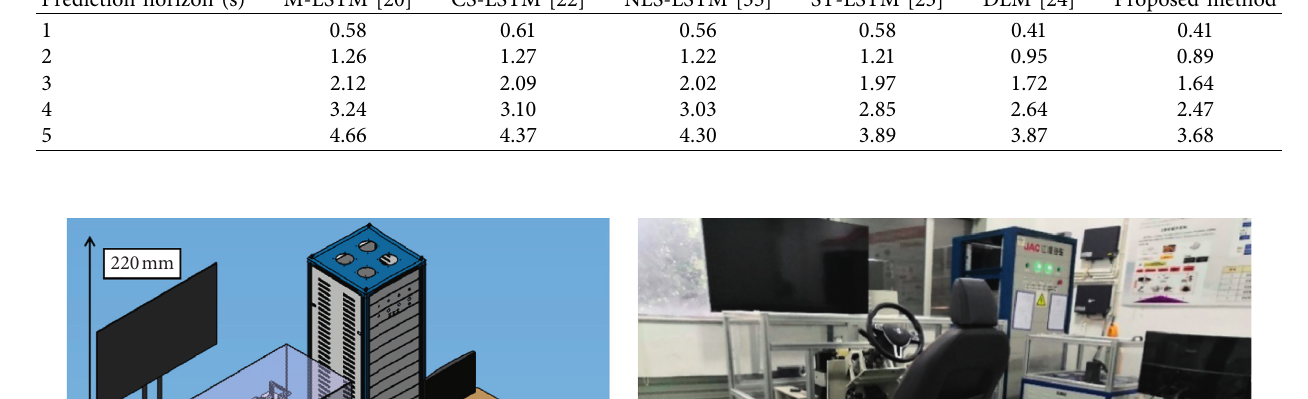
Figure 13: Effectiveness of considering prediction reference baseline in the vehicle trajectory prediction: (a) lateral position error; (b) longitudinal position Table 2: RMSE comparison of the proposed method with the baseline models and state-of-the-art model. Prediction horizon (s)